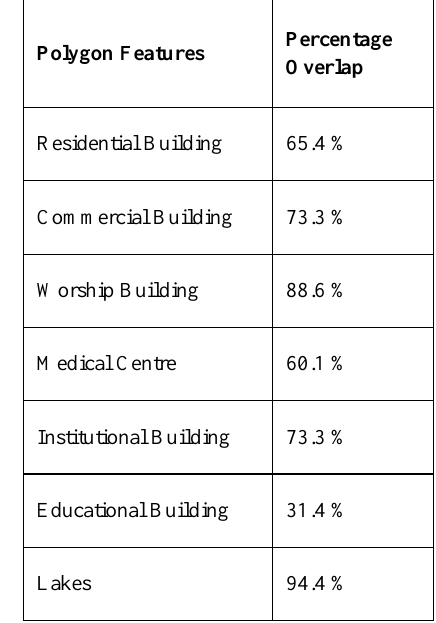
Table 4: Comparison of overlaps according to the different type of polygon